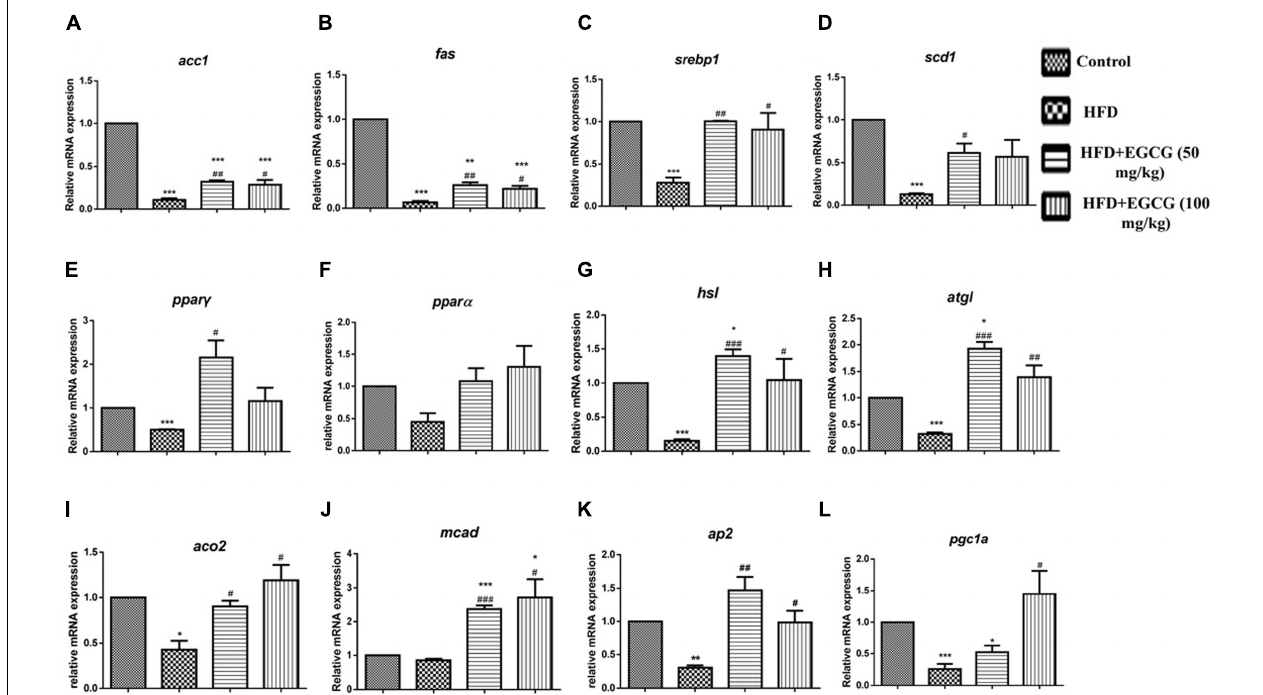
FIGURE 4 | Effect of EGCG on the expression of genes involved in lipogenesis, oxidation, and transportation in subcutaneous adipose tissues of mice. Total RNA extracted from subcutaneous white adipose tissue was used for mRNA expression analysis of genes involved in fatty acid synthesis [ (A–E) acc1 , fas , srebp1 , scd1 , and ppar γ ], lipolysis [ (F–J) ppar α , hsl , atgl , aco2 , and mcad ], lipid transportation and thermogenesis [ (K–L) ap2 , pgc1 α ]. Values are the mean ± SEM ( n = 3/4 each group). ∗ P < 0.05; ∗∗ P < 0.01; ∗∗∗ P < 0.001 vs. control. # P < 0.05; ## P < 0.01; ### P < 0.001 vs. HFD.